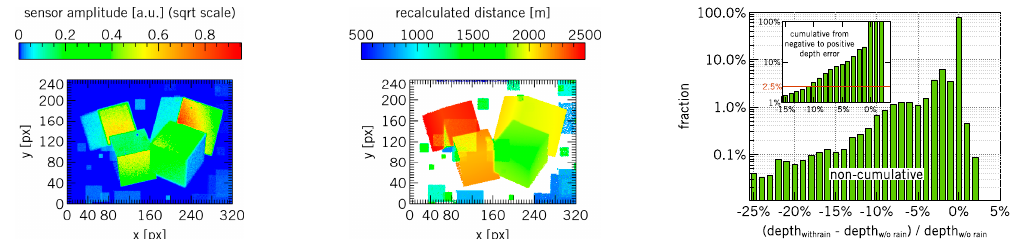
Figure 4. Relative intensity ( left ); re-calculated depth ( center ); and corresponding depth accuracy error ( right ) for “worst case” rain model (mix of different particle sizes with high overall